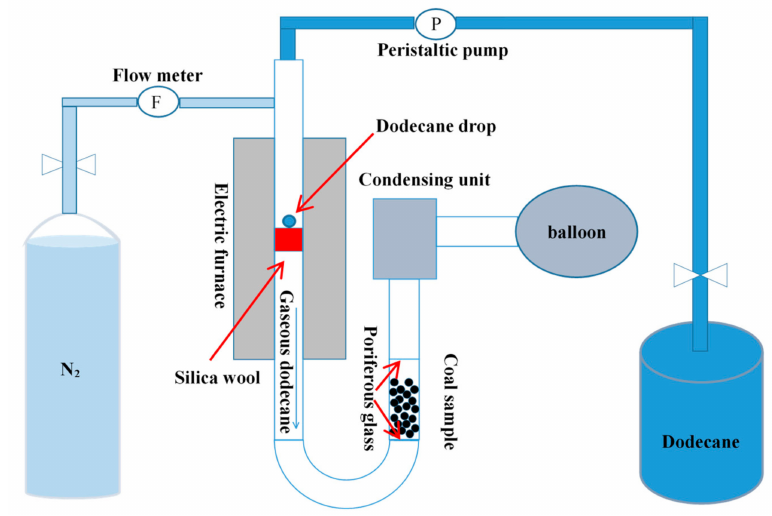
Figure 1. Schematic of the gaseous pretreatment